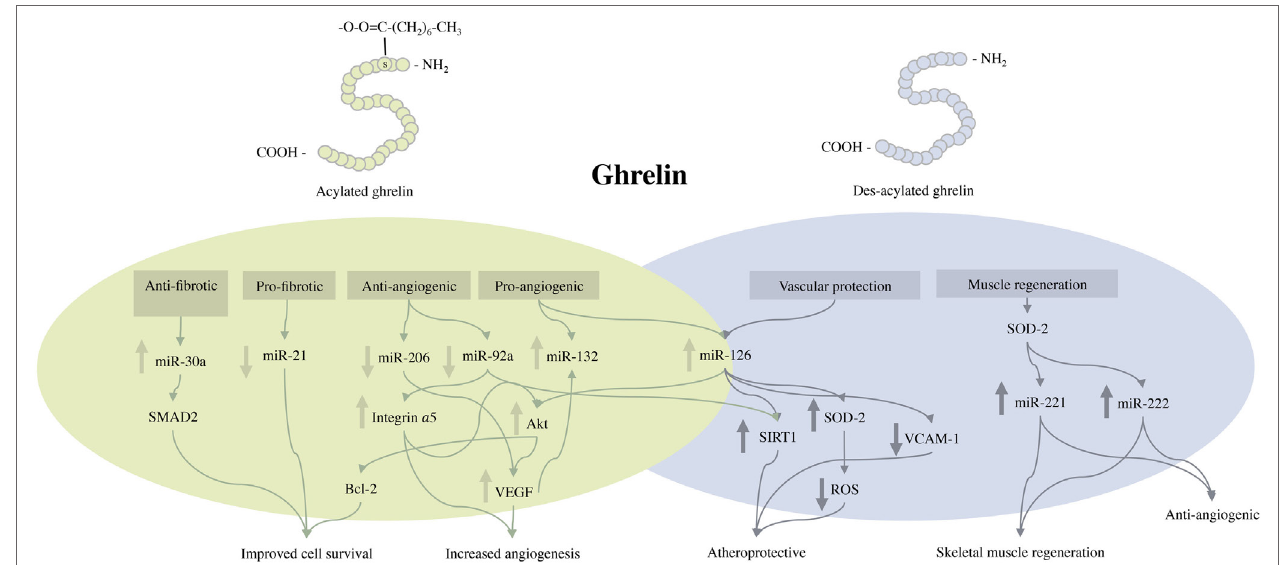
FiGURe 1 | Schematic representation of the structure of acylated and des-acylated ghrelin and the proposed molecular events activated by exogenous ghrelin treatment following critical limb ischemia. miR, indicates microRNA; VEGF, vascular endothelial growth factor; Akt, protein kinase B; Bcl-2, B-cell lymphoma 2; SIRT1, surtuin 1; VCAM-1, vascular cell adhesion molecule 1; SOD-2, superoxide dismutase-2; ROS, reactive oxygen